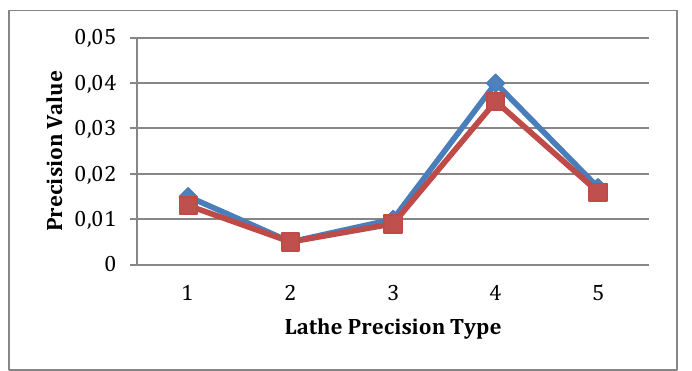
Figure 7: Alternative based criterion weight variation